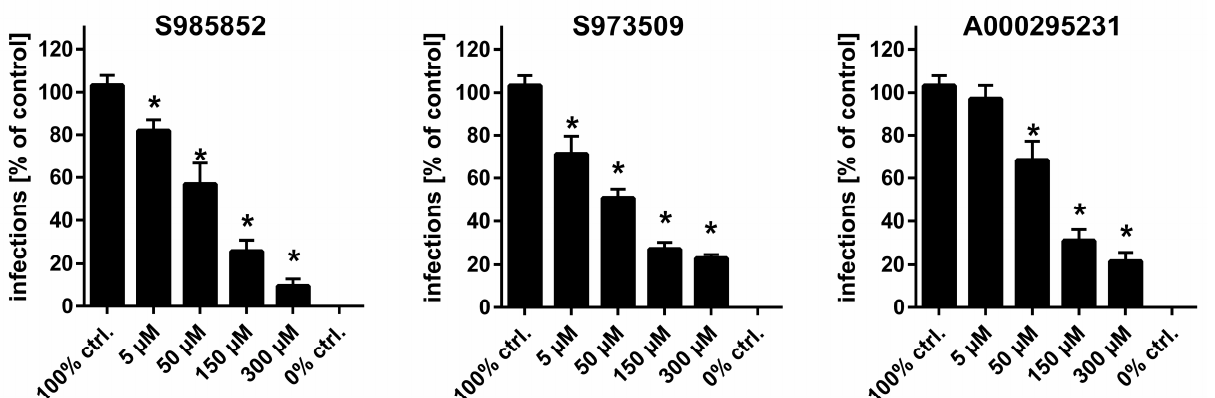
Figure 5. HDV infection studies. NTCP-HepG2 cells were pre-incubated for 5 min with the indicated concentrations of the indicated inhibitors in DMEM at 37 ◦ C. Then, cells were additionally inoculated with 120 genome equivalents/cell of HDV particles at 37 ◦ C. After 6 h, cells were washed and further incubated with inhibitor- and virus-free medium, and medium was changed every 3–4 days. At day 9 post infection, cells were fixed and an immunostaining against the HDAg was performed, as a marker of HDV infection. The number of infected cells per well was determined by fluorescence microscopy. NTCP-HepG2 cells incubated without inhibitor were used as control (set to 100% infection rate). Infection experiments in the presence of 0.5 µ M myr-preS1 2-48 lipopeptide served as 0% control (representing 0% infection rate). Data represent means ± SEM of three independent experiments, each with triplicate determinations ( n = 9). * Significantly different to 100% control wit p < 0.01.